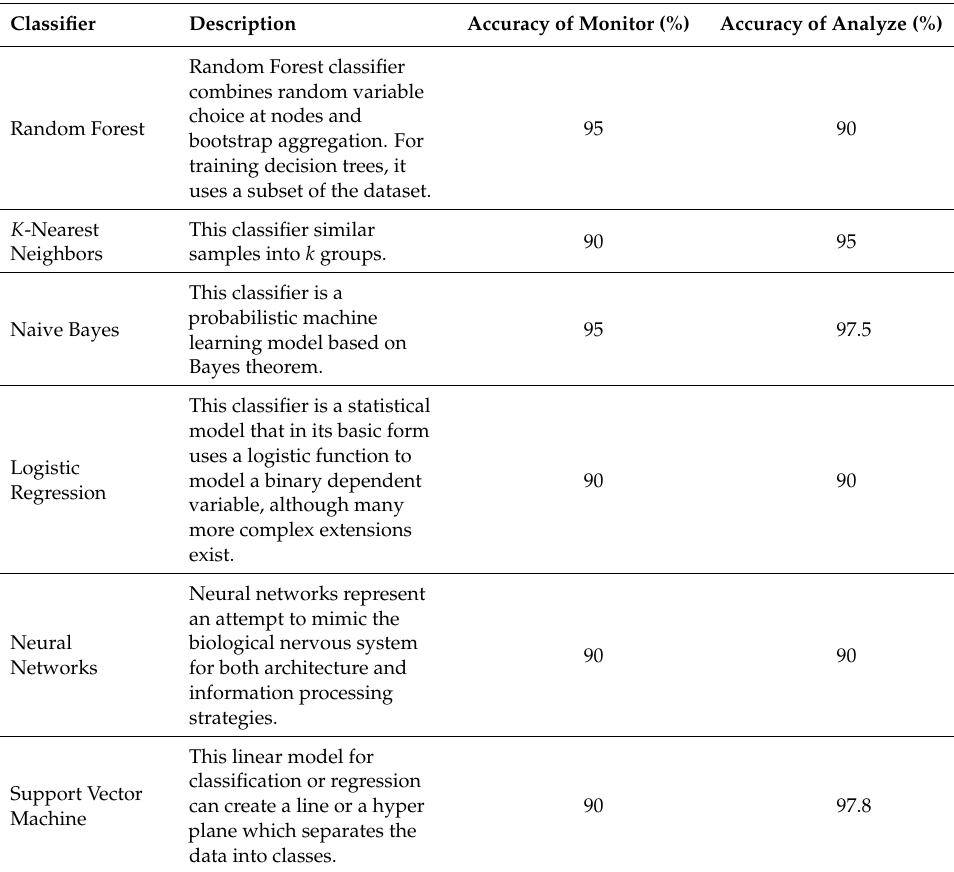
Table 3. Accuracy of supervised algorithms when used by monitor and analyze